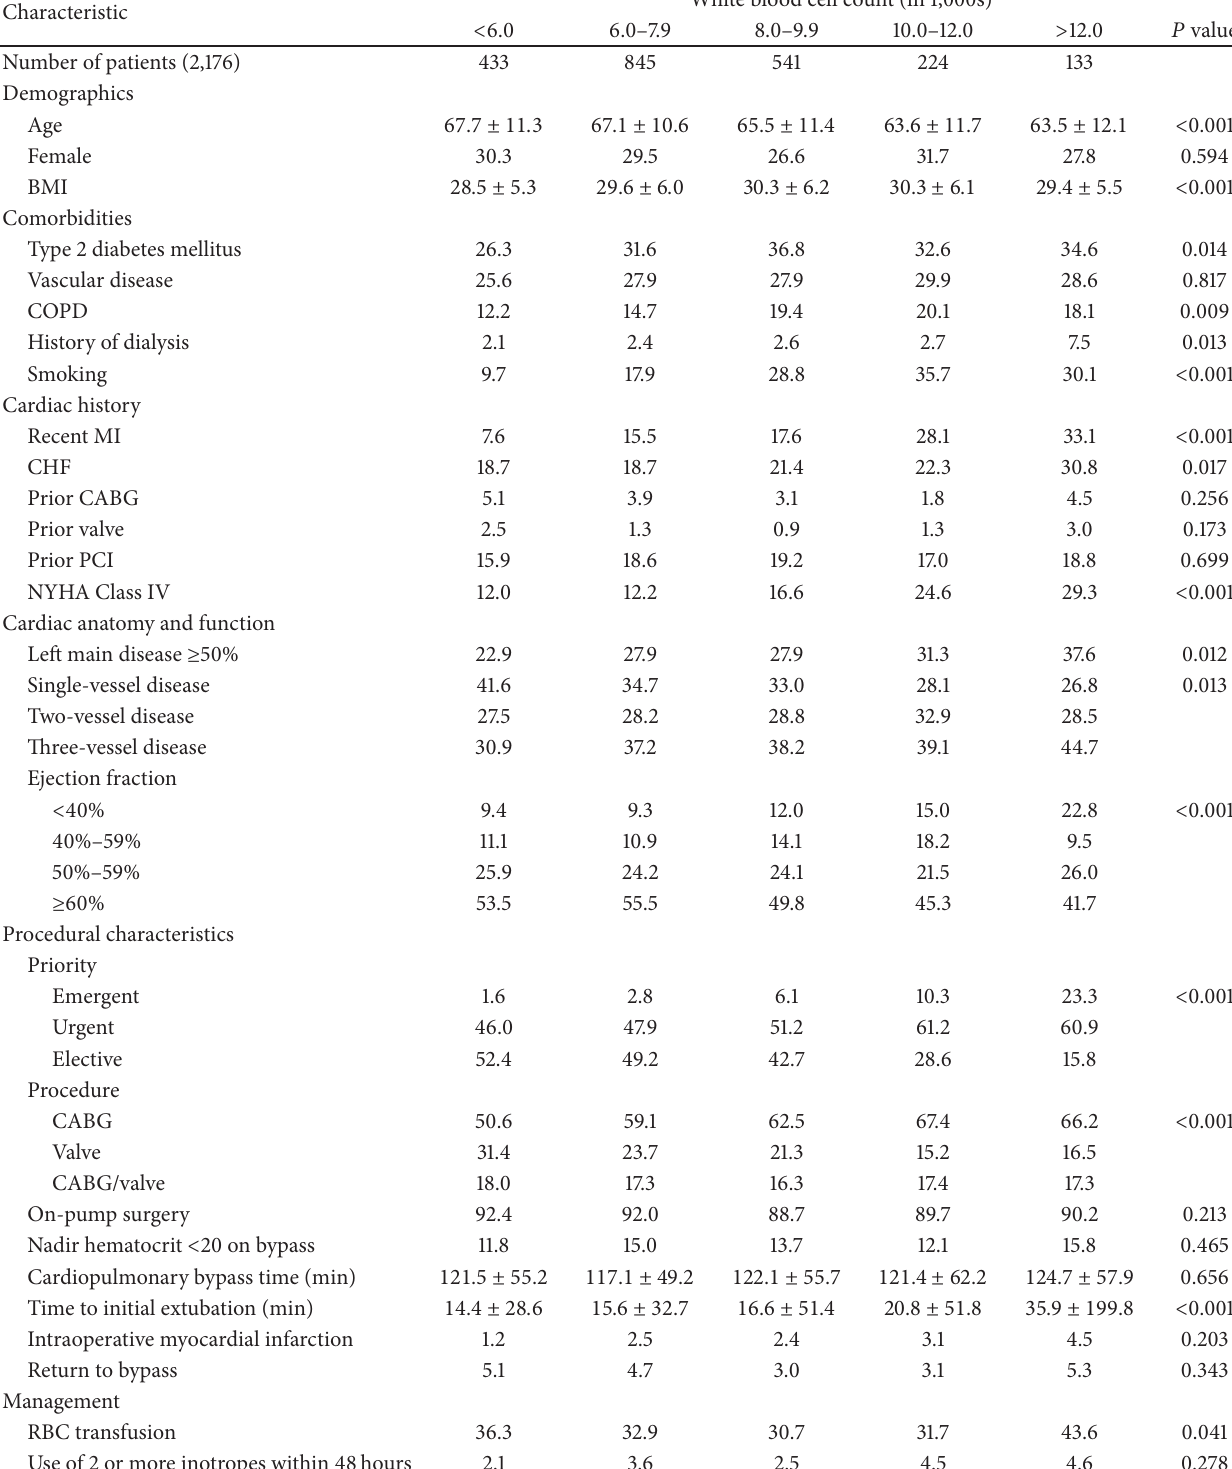
Table 4: Characteristics of patients and white blood cell count